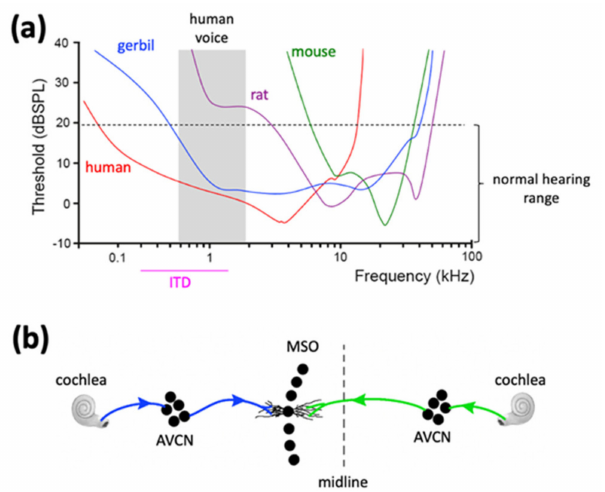
Figure 2. Human-like hearing ability and auditory brainstem circuit in Mongolian gerbils. ( a ) Rodent and human audiograms. Gerbils (blue), but not mice (green) or rats (purple), have good (low thresholds) low-frequency hearing, comparable to humans (red). The shaded area is the frequency range for the human voice. Threshold < 20 dB is usually considered normal hearing. Humans use low-frequency sounds (below 1500 Hz) for ITD computation. The figure is built upon published studies [98,99,107,130,131]. ( b ) The schematic shows the MSO circuit for ITD computation, which is conserved across vertebrate species that are sensitive to low-frequency sounds. As an underlying substrate of this function, bipolar dendrites of MSO neurons receive segregated inputs from the ipsilateral (blue lines) and contralateral (green lines) ears through the AVCN. Abbreviations: ITD, interaural time difference; MSO, medial superior olive; AVCN, anteroventral cochlear nucleus; FMRP, Fragile X mental retardation